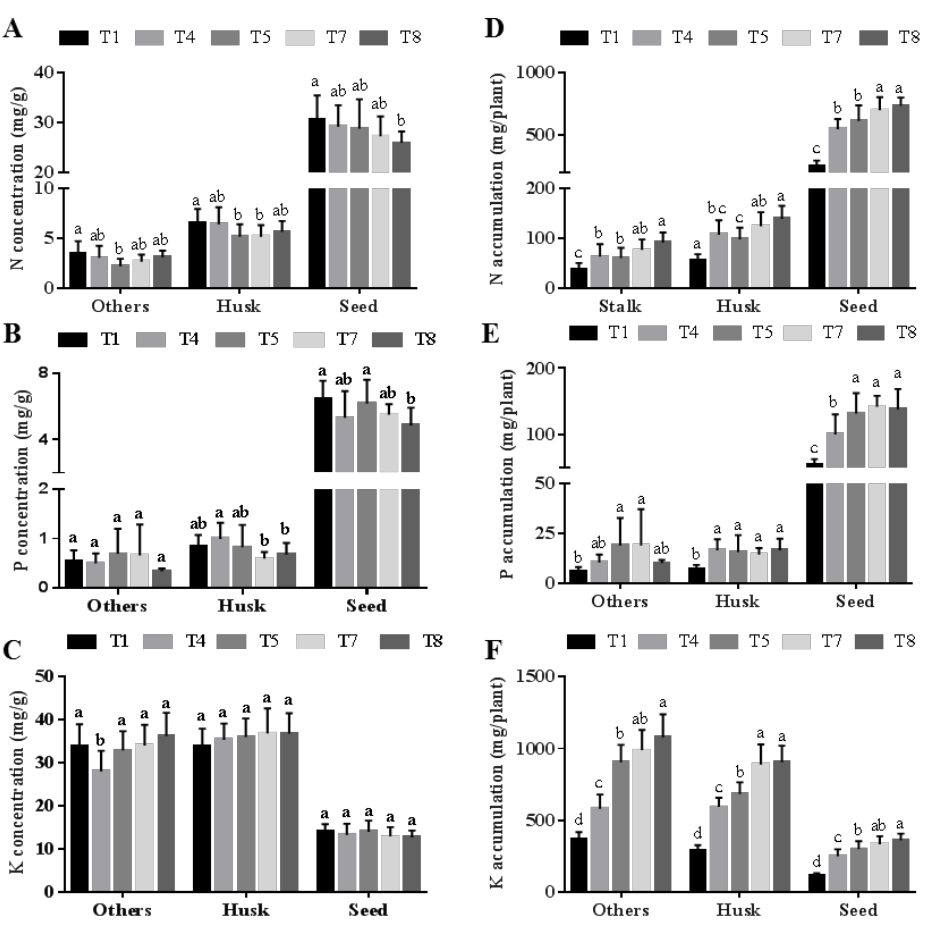
Figure 9. Mineral concentration in three parts of Brassica napus at the mature stage under different treatments. Ten different treatments were conducted in the field trial. Among them, four treatments were selected to investigate the nutrient concentrations. No fertilizer was applied in T1 treatment.